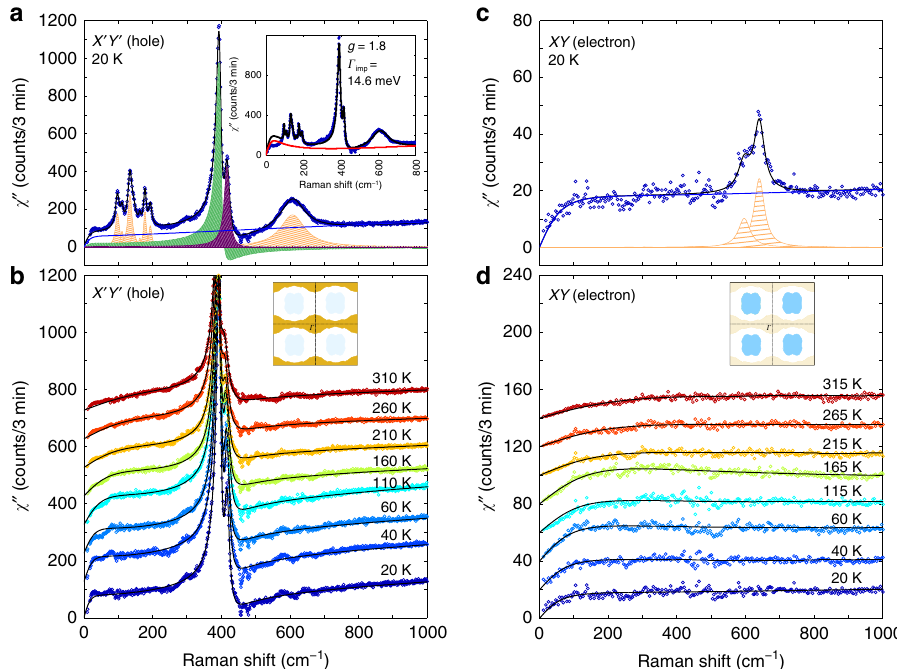
Fig. 3 Fits with MFL model to extract electronic Raman scattering response. a Raman spectrum at 20 K in X 0 Y 0 (blue circles), with the details of the fi t to our phenomenological marginal Fermi-liquid model (solid line in black, see text). The solid line in blue is the best-suited e -continuum scattering according to the marginal Fermi-liquid (MFL) model in Eq. (4). Phonon modes are shaded in orange (Lorentzian lineshape) and green or purple (Fano lineshapes). The inset displays a representative attempt to fi t these data with Fermi-liquid model. b Temperature dependence of the X 0 Y 0 Raman spectra, after subtraction of the symmetrical (Lorentzian) phonon lines. The data were vertically shifted for representation. The solid lines are the best-suited e - continuum scattering backgrounds according to the MFL model, including the coupling to the phonons ~400 m − 1 . c Raman spectra ( χ ″ ( ω )) in XY at 20 K. d Temperature dependence of the electronic part or the Raman response in XY . The data were vertically shifted for representation. The solid lines are the best-suited e -continuum scattering backgrounds according to the MFL